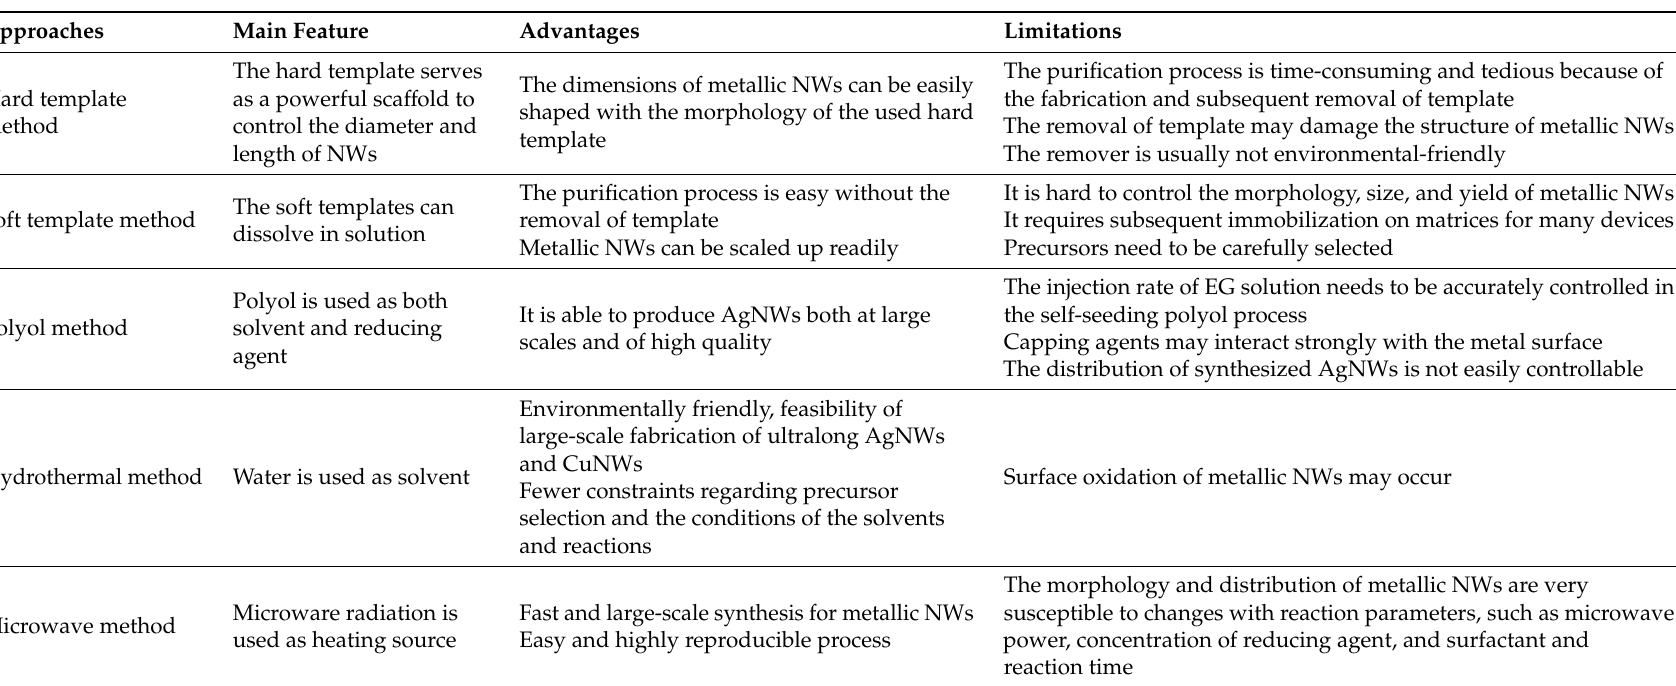
Table 1. Main feature, advantages and limitations of fabrication techniques of metallic